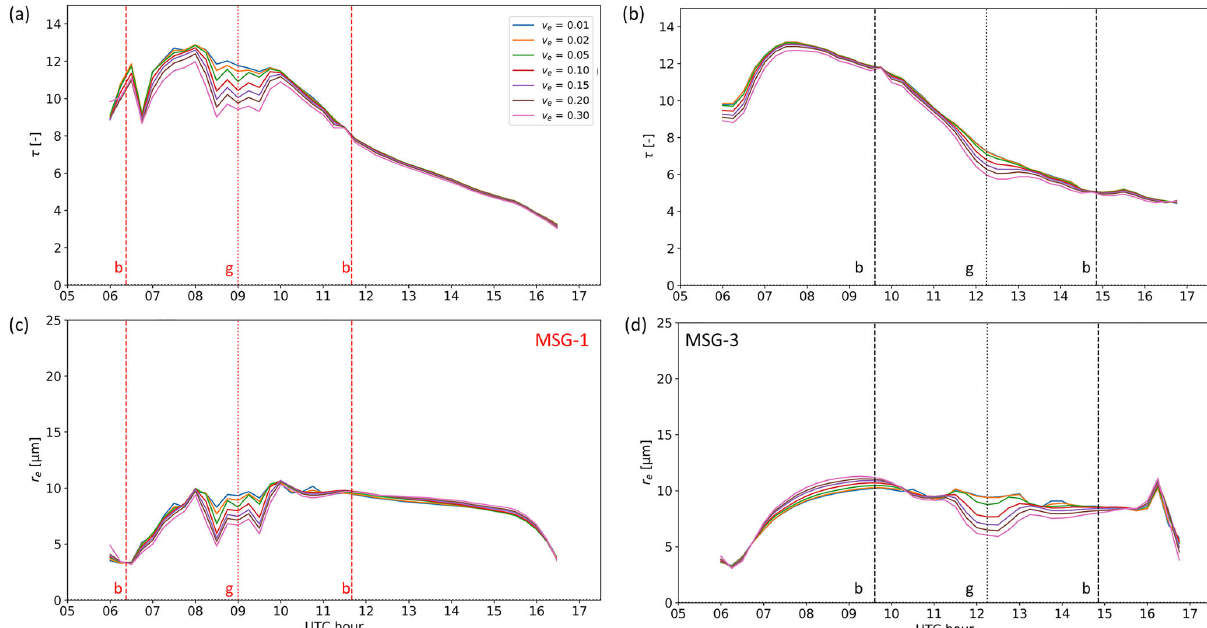
Figure 10. CPP retrievals of τ (a, b) and r e (c, d) based on the 3.9µm channel, shown separately for MSG-1 (a, c) and MSG-3 (b, d) , for the seven values of ν e examined on 7 March 2017 over the southeastern Atlantic. The seven ν e values are shown in (a) . The vertical lines represent cloud glory (dotted, denoted with “g”) and cloud bow (dashed, denoted with “b”) geometries for MSG-1 (red) and MSG-3 (black).